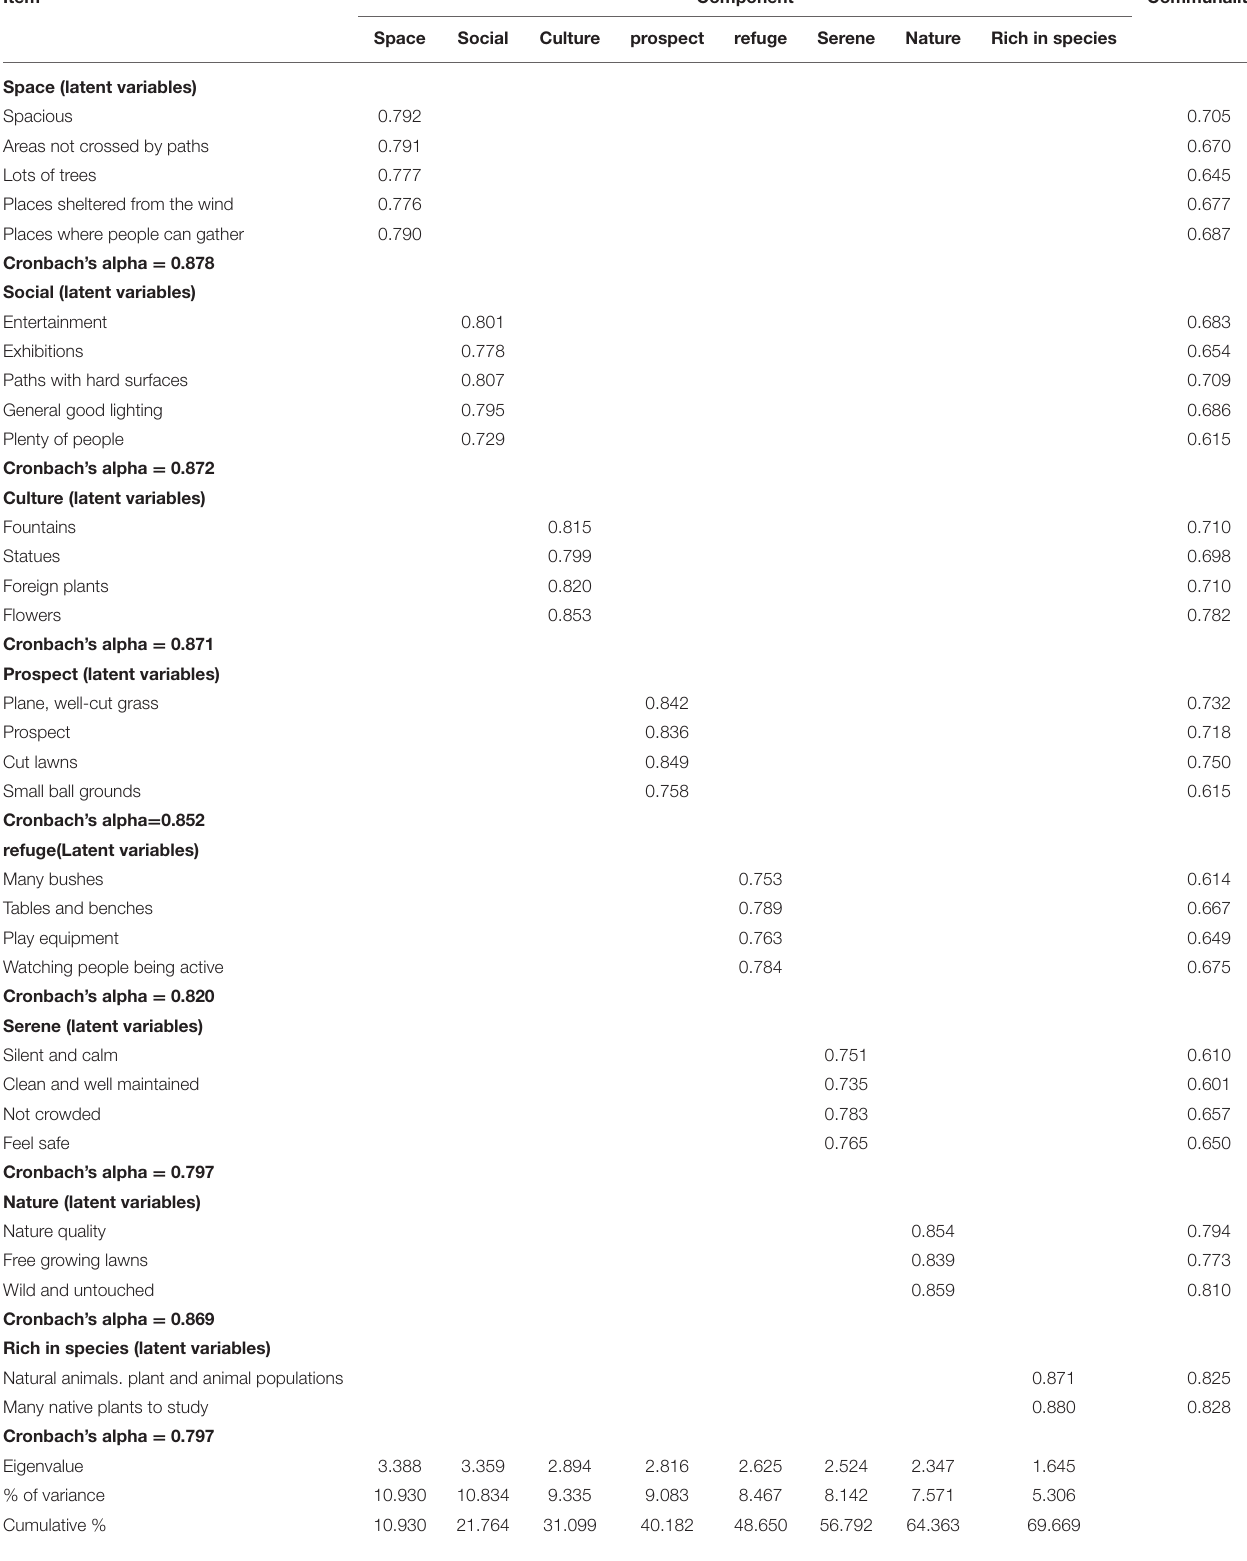
TABLE 3 | Corrected correlations between PSDs items and